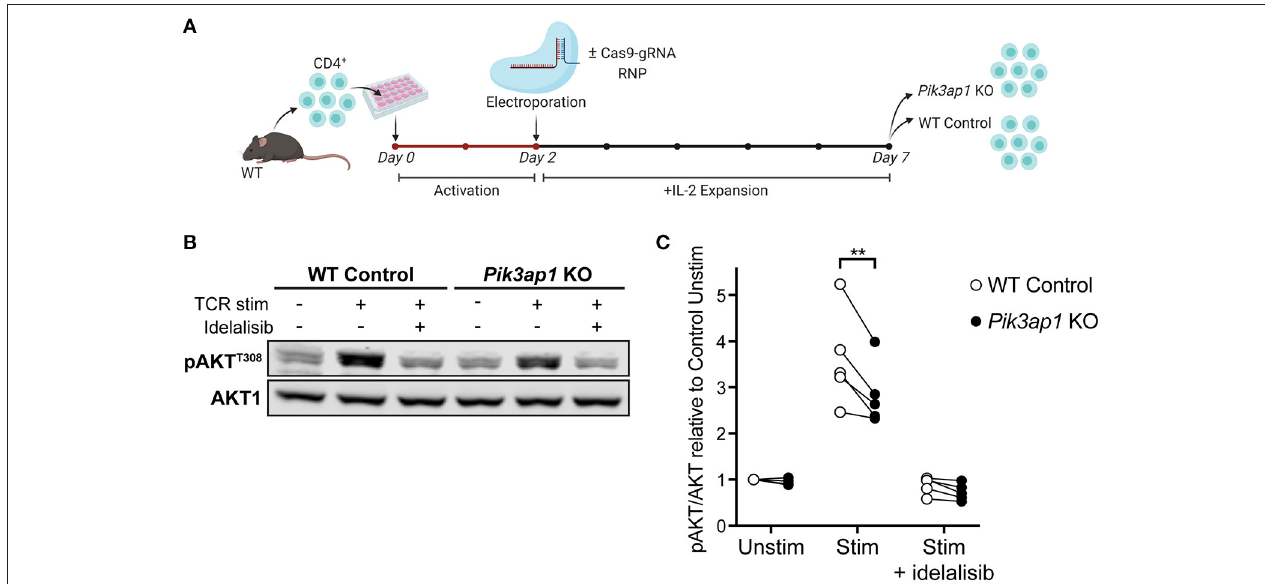
FIGURE 4 | TCR-induced p110 δ -AKT signalling is impaired in BCAP-deficient activated CD4 + T cells. (A) Schematic of the CRISPR-Cas9 gene editing protocol used to generate Pik3ap1 -KO T cell blasts. Naïve CD4 + T cells from the lymph nodes of one WT mouse were activated in vitro with anti-CD3 + anti-CD28 for 48h then electroporated with (for Pik3ap1 KO) or without (for WT Control) Cas9-gRNA RNPs targeting Pik3ap1 exon 4. Cells were then expanded with IL-2 for 5 days. Pik3ap1 knockout was confirmed on day 5 by sequencing and Tracking of Indels by Decomposition analysis, as described in Supplementary Figure 5 . Cells were rested for 1.25h before TCR stimulation on day 7. (B) Immunoblot for pAKT T308 in Pik3ap1 -knockout and WT-control CD4 + T cell blasts following TCR stimulation for 2min by CD3-CD4-crosslinking ( + ), or without stimulation (–), in the presence or absence of 200nM idelalisib. AKT1 was detected as a loading control. Immunoblot representative of five biological repeats. (C) Quantification of pAKT T308 detected by immunoblotting in Pik3ap1 -knockout and WT-control CD4 + T cell blasts, stimulated as described in (B) . pAKT T308 was normalised to the AKT1 loading control and is expressed relative to that in unstimulated WT-control cells. The lines on the spaghetti plot connect Pik3ap1 -knockout (black circles) and WT-control (white circles) cells from the same mouse and experiment. Data are from five biological repeats. Significance was determined by a ratio paired t -test; ** p = 0.0088.